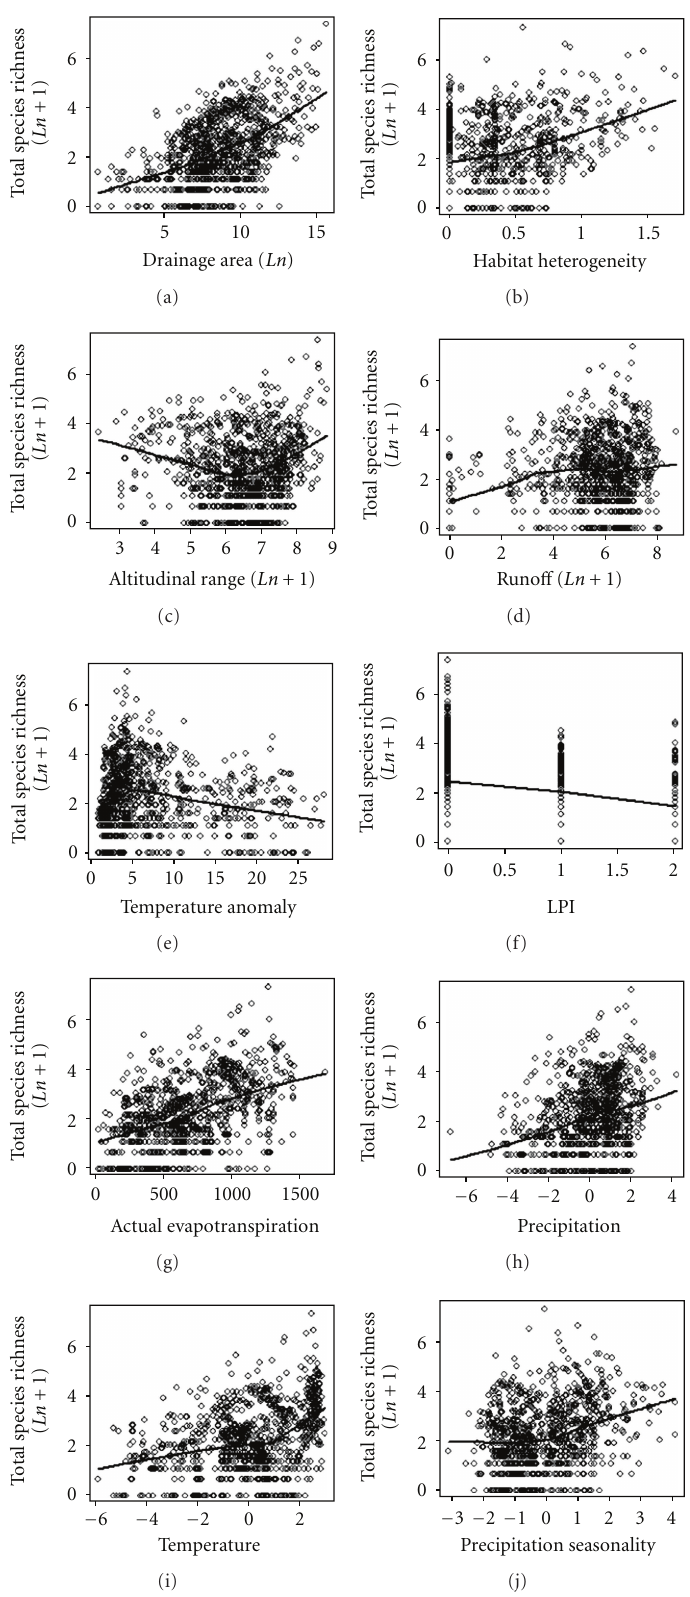
Figure 2: Fish species richness for each river basin as a function of drainage area (a), habitat heterogeneity (b), altitudinal range (c), runo ff (d), temperature anomaly (e), LPI (Land-Peninsula-Island) (f), actual evapotranspiration (g), precipitation (h), temperature (i), and precipitation seasonality (j). See Table 1 for variables